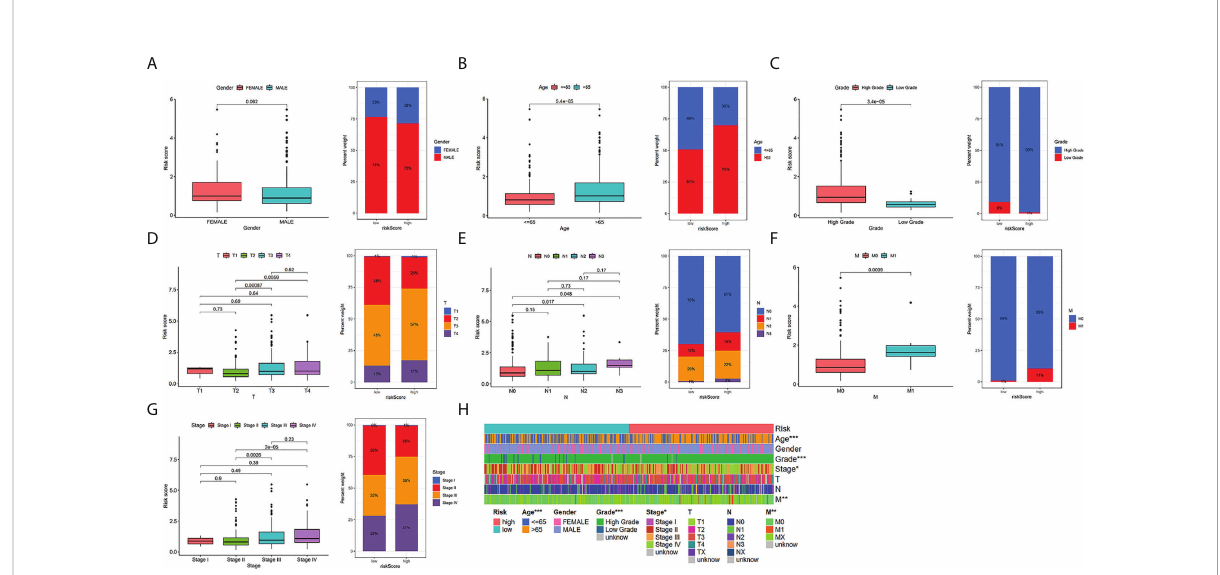
FIGURE 4 Relationship between risk scores and clinical characteristics in TCGA-BLCA cohort. Relationship between risk score and gender (A) , age (B) , grade (C) , T stage (D) , N stage (E) , M stage (F) ,tumor stage (G) . The heatmap shows the relationship among gender, age, grade, T stage, N stage, M stage, tumor stage and the risk score (H) . * P < 0.05, ** P < 0.01, and *** P <